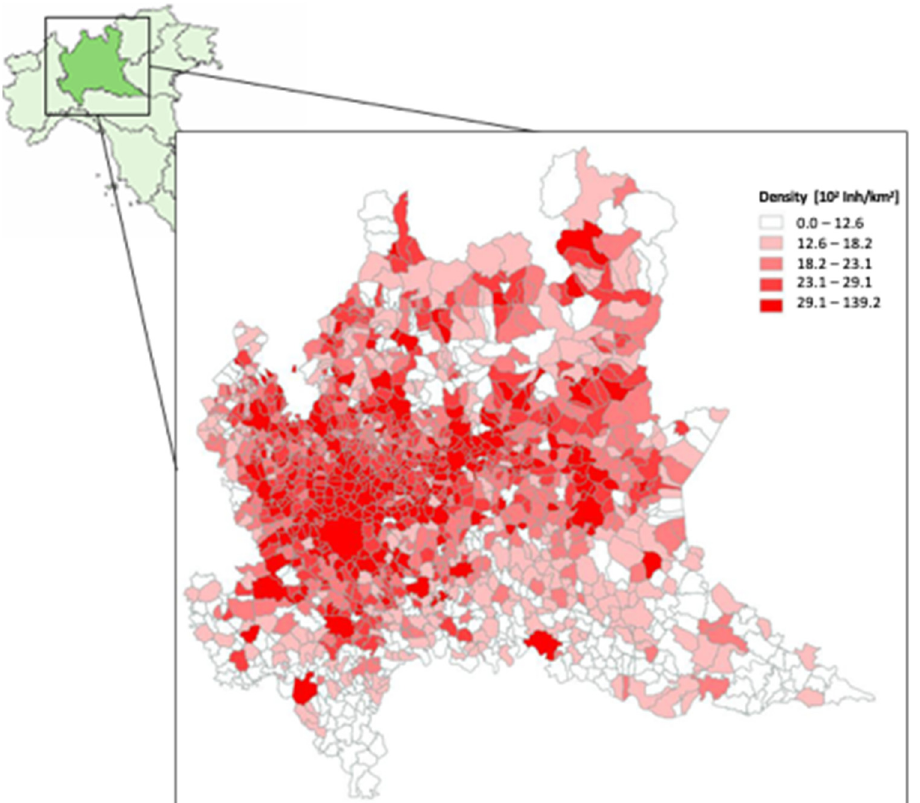
Figure 1. Municipalities of the Lombardy region: colors represent the density of the population in their urban area calculated from regional land use [33] and census [34] data.